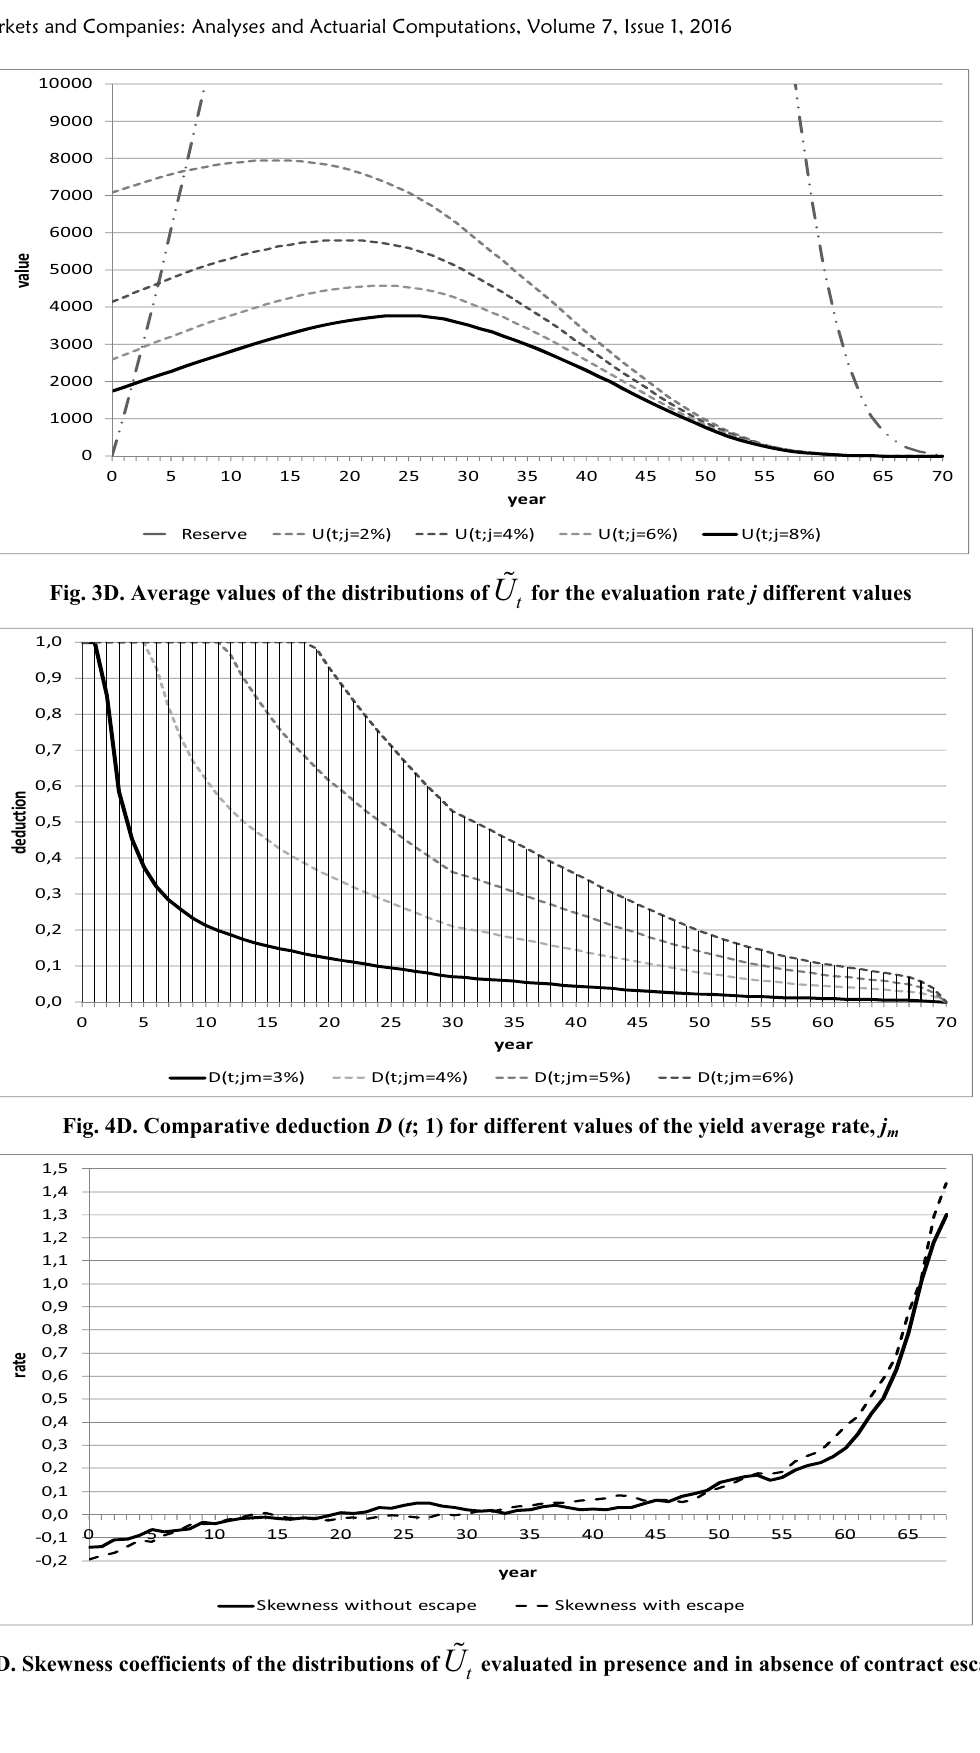
Fig. 5D. Skewness coefficients of the distributions of